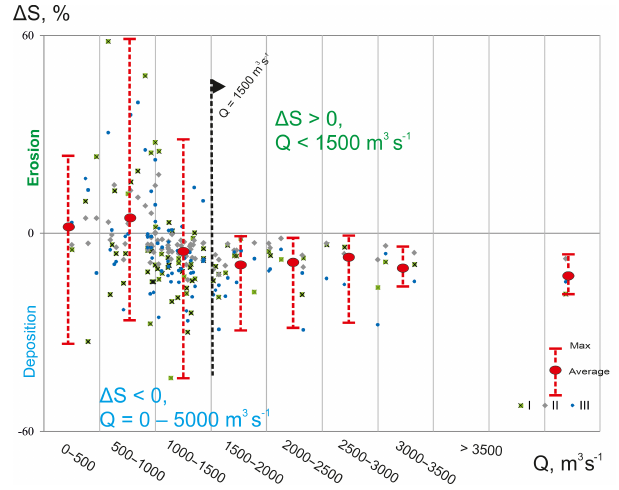
Figure 2. Suspended sediment retention (%) changes within the Selenga delta under different discharge ( Q ) conditions (I, II, III – delta sectors according to Fig.